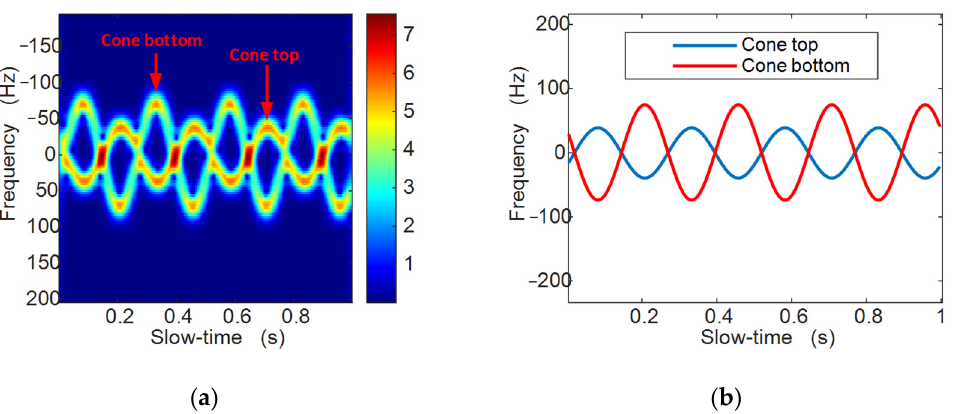
Figure 7. Simulations of the micro-Doppler effect of the precession cone-shaped target perpendicular to the radar LOS. ( a ) Echo micro-Doppler frequency curves. ( b ) Theoretical micro-Doppler frequency curves.